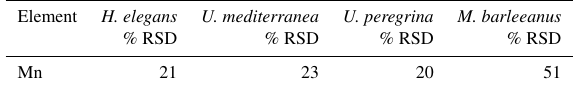
Table 4. Relative standard deviation (% RSD) of intraindividual values in Mn / Ca within four species of benthic foraminifera (